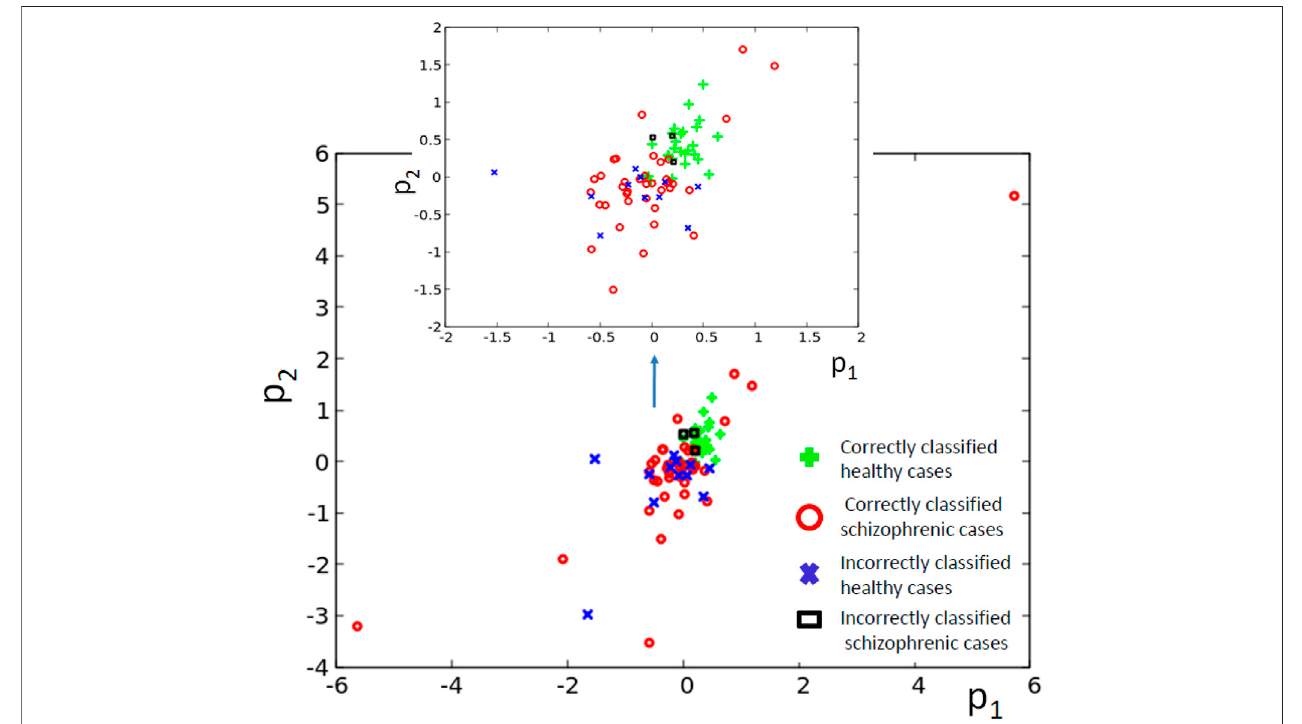
FIGURE 6 | The distribution of correctly and incorrectly classi fi ed cases for 3-oscillator network (cf. Figure 2A ) in the phase space ( p 1 , p 2 ).